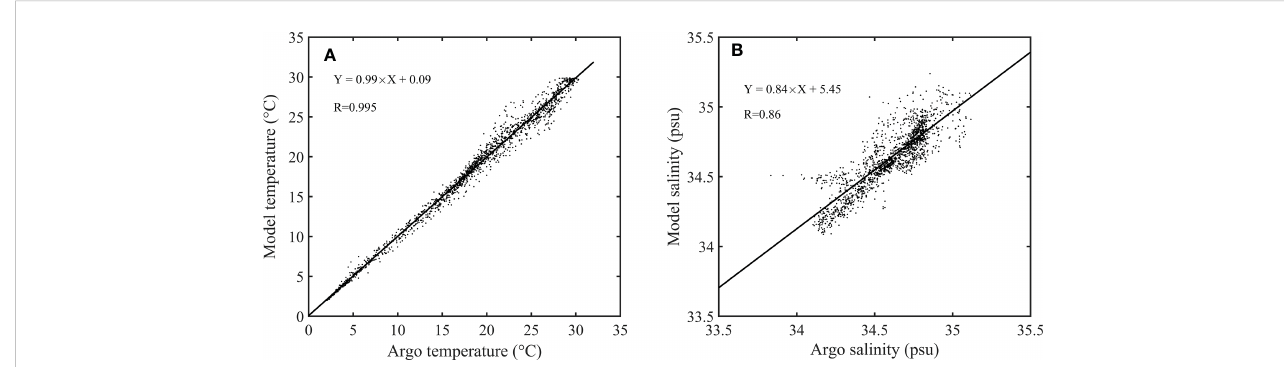
FIGURE 2 Comparisons of Argo observations with the corresponding results of EXP HYCOM for (A) temperature and (B) salinity. In the linear fi tting formulas, Y is the model results, and X is the corresponding Argo observations. R is the correlation coef fi cient between the model results and Argo